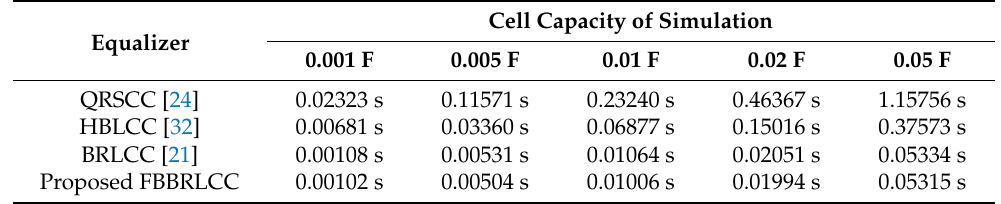
Table 3. Simulation comparison of the influence of different cell capacities on balancing time under the initial voltages #2.